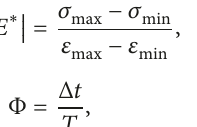
The stresses and strains were extracted after running for 0.1 s (two periods), and the stress and strain curves were plotted in Figure 2. Dynamic moduli and phase angles from the